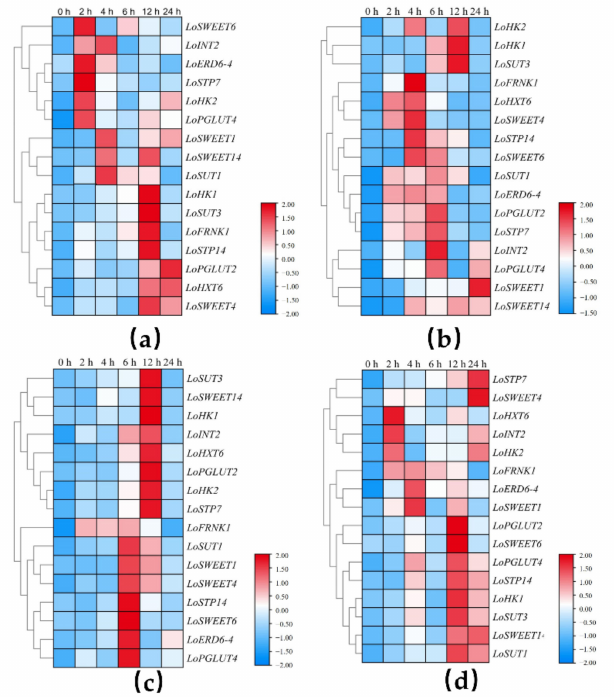
Figure 9. Expression heatmap of ST genes after cold ( a ), ABA ( b ), mannitol ( c ) and NaCl ( d ) treatments in